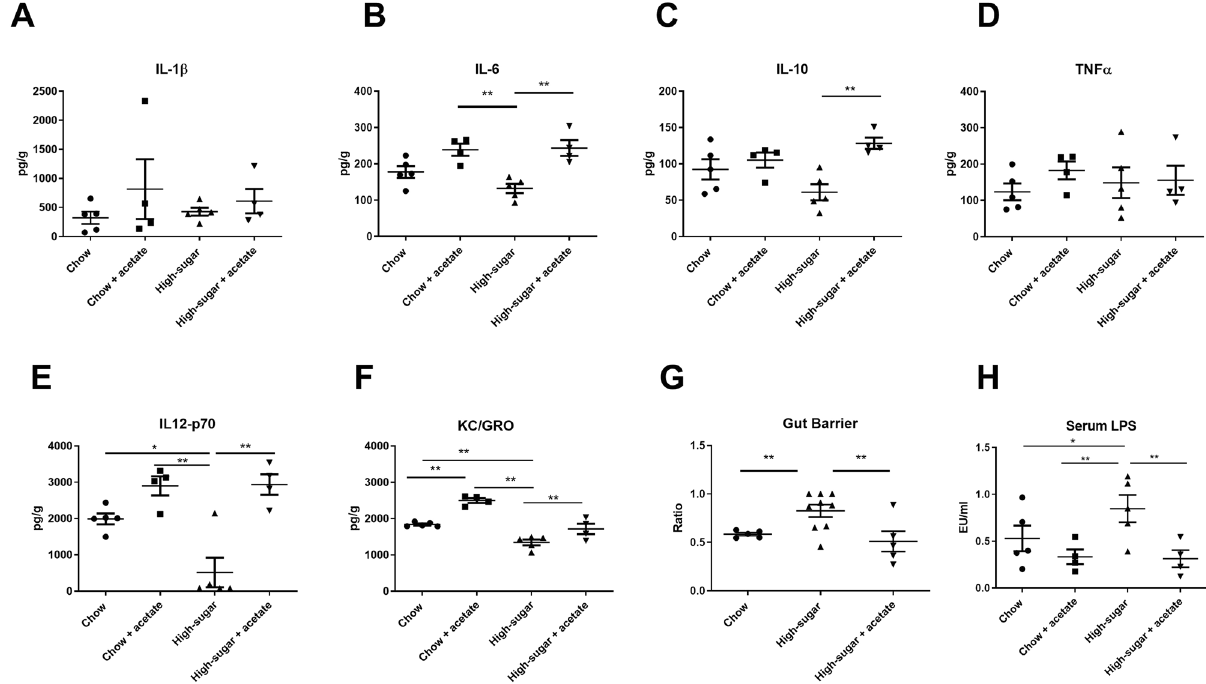
Figure 2. Effects of a high sugar diet and acetate supplementation on colonic tissue cytokines and barrier function. Colonic tissue concentrations of IL-1 β ( A ), IL-6 ( B ), IL-10 ( C ), TNF α ( D ), IL-12p70 ( E ), and KC/ GRO ( F ). Two days of high-sugar diet significantly decreased IL-12p70 and KC/GRO levels compared to chow fed mice. Oral acetate supplementation in a high-sugar diet elevated the concentration of IL-6 ( B ), IL-10 ( C ), and IL-12p70 ( E ). Barrier function following two days of a high-sugar diet as measured by the ratio of 70 kDa/4 kDa dextran movement through intestinal loops ( G ) and serum LPS levels ( H ). Mice on a high- sugar diet had an increased ratio representing a decrease in barrier function compared to chow-fed mice and increased serum LPS compared with chow, chow + acetate, and HS + acetate fed mice. Acetate supplementation normalized intestinal barrier function. Data is shown as mean ± SEM. Chow: n = 5; HS: n = 5; Chow + acetate: n = 4; HS + acetate: n = 4. ** p < 0.01; * p <